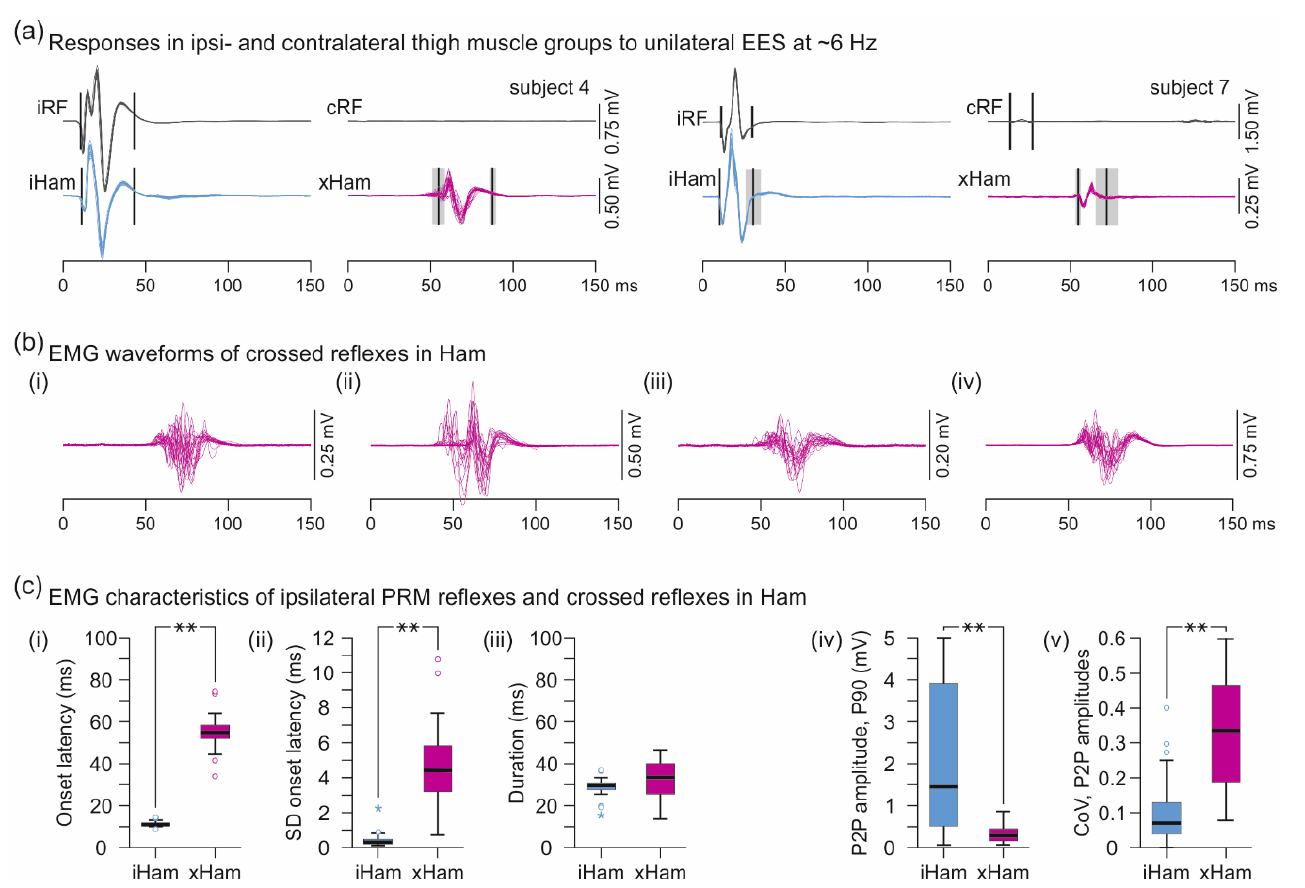
Figure 2. EMG characteristics of crossed reflexes in the hamstrings muscle group (Ham) evoked by unilateral EES at ~6 Hz. ( a ) EMG recordings of ipsilateral monosynaptic PRM reflexes in rectus femoris (RF) and Ham and crossed reflexes in Ham evoked by EES over the right lumbar posterior roots, subjects 4 and 7. No responses were evoked in the tibialis anterior and the triceps surae muscle group (not shown). Black vertical lines mark mean onset and offset latencies; shaded areas are SDs. ( b ) Crossed reflexes in Ham with considerable variations of EMG waveforms. All examples derived from subject 4, ( i ) and ( ii ), recording 1, left Ham, electrode setup 2+3 − , 5 V and 8 V, respectively; ( iii ), recording 2, right Ham, 2+3 − , 7 V; (iv), recording 3, left Ham, 1+3 − , 6 V. Twenty stimulus-triggered EMG traces shown superimposed in each panel. ( c ) Boxplots of ( i ) onset latencies; ( ii ) SDs of onset latencies; ( iii ) EMG response durations; ( iv ) 90th percentiles (P90) of EMG peak-to-peak (P2P) amplitudes; and ( v ) coefficients of variation (CoV) of the EMG P2P amplitudes shown separately for the ipsilateral monosynaptic PRM reflexes and the crossed reflexes in Ham. Circles illustrate outliers and asterisks extreme values. c, contralateral; EES, epidural electrical stimulation; i, ipsilateral; PRM, posterior root-muscle; SD, standard deviation; x, crossed reflex; **, p < 0.001.